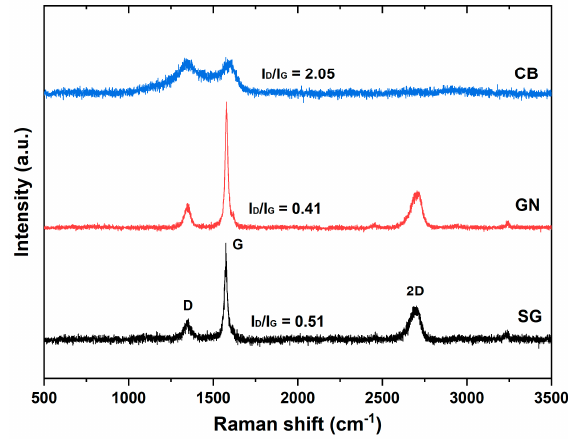
Figure 2. Raman spectra of the carbon fillers used.